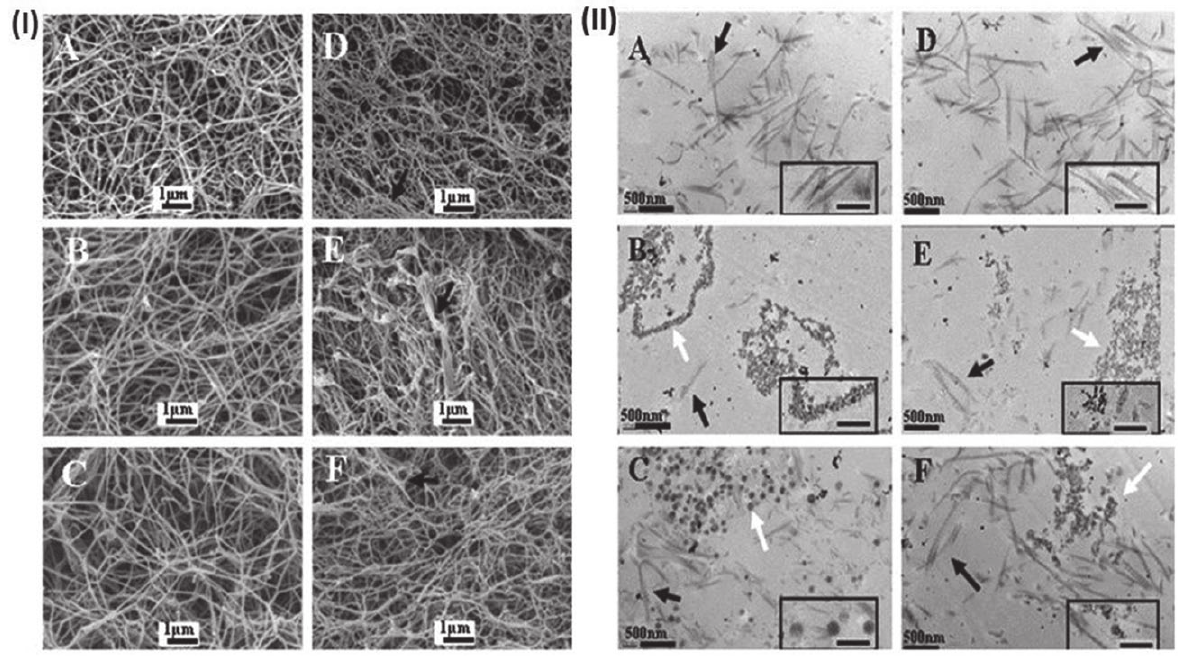
Figure 5 (I) SEM images of collagen (A, D), Si12-collagen (B, E) and Si80-collagen (C, F) composite hydrogels after 1 day (A – C) and 21 days (D – F) of incubation, in which the local fiber aggregations are shown by dark arrows. (II) TEM images of collagen (A, D), Si12-collagen (B, E) and Si80-collagen (C, F) composite hydrogels after 1 day (A – C) and 21 days (D – F) of incubation, in which collagen fibrils and silica nanopar- ticles are marked with dark and white arrows, respectively, according to Desimone et al. [21] . Reproduced with permission from Elsevier.